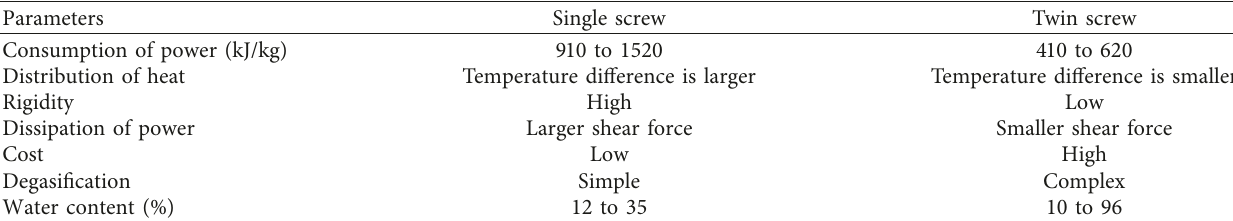
Figure 4: Novel method to develop an acoustic panel using natural fiber-reinforced composite. Table 16: Difference between single screw and twin screw extruder